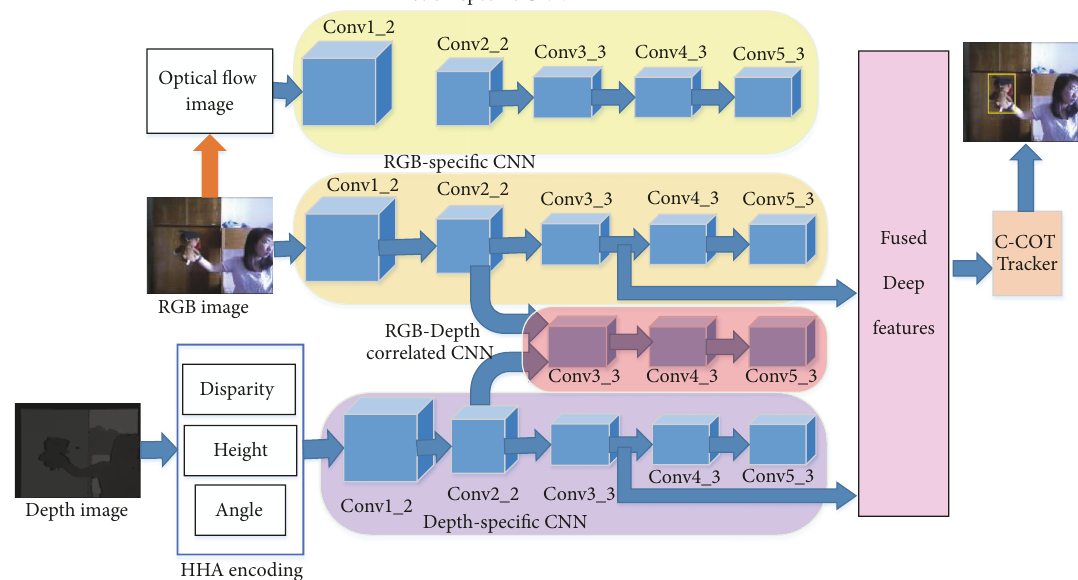
Figure 1: Our MMDFF model for RGB-D